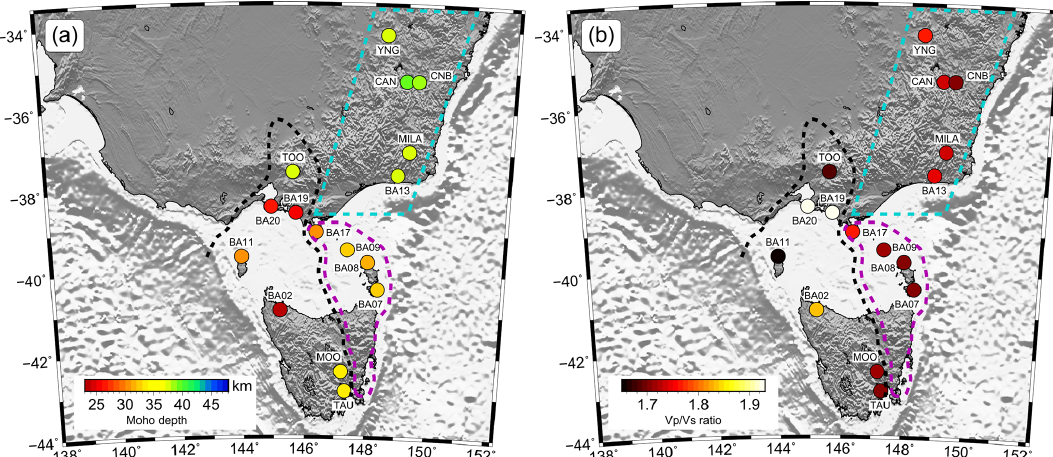
Figure 6. (a) Variations in the crustal thickness and (b) V p /V s ratio taken from the linear ( H – κ ) stacking results (Table 2). Crustal thickness varies between ∼ 23 and 39km. The V p /V s ratios vary from ∼ 1.65 to 1.93. The thick black dashed line denotes the boundary of VanDieland. The thick magenta dashed line outlines the boundary of the East Tasmania Terrane and eastern Bass Strait (ETT + EB). The thick cyan dashed line highlights the eastern part of the Lachlan Fold Belt. The illuminated topography and bathymetry are based on the ETOPO1 dataset (Amante and Eakins, 2009). Table 2. Summary of H – κ stacking and NA inversion results for the current